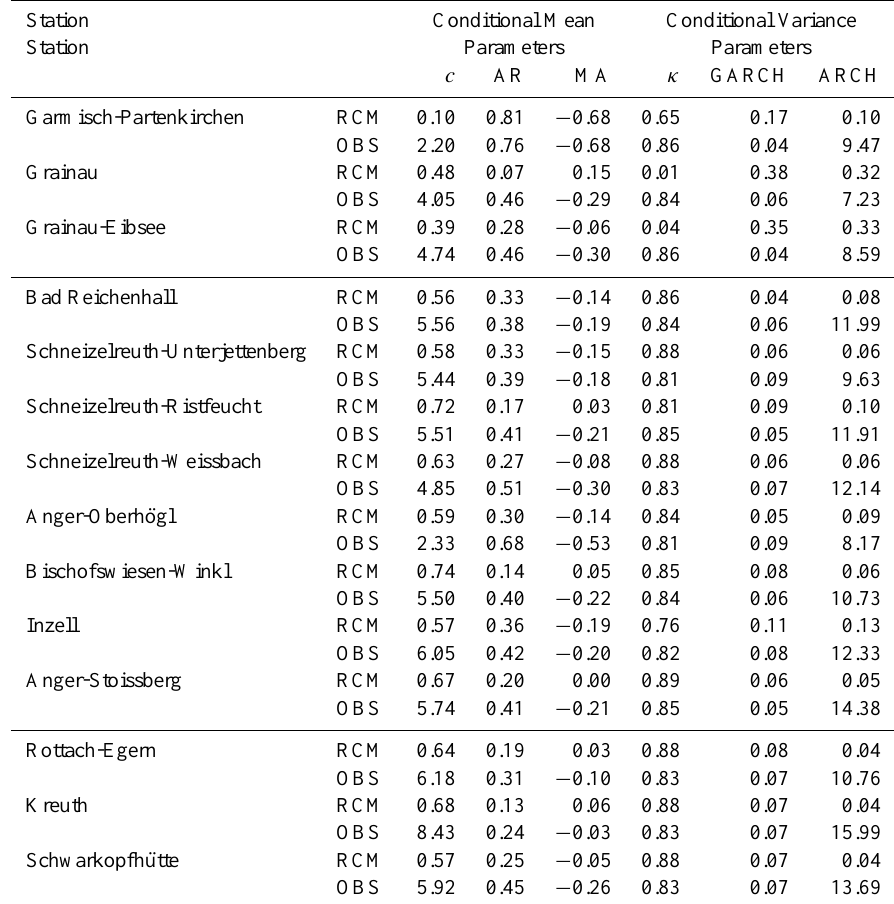
Table 3. Parameters for the fitted ARMA(1,1)-GARCH(1,1) models for selected stations (OBS) and their corresponding RCM grid cells (see Table 1 for further details about the stations). The conditional mean parameters of the ARMA model consist of c , the conditional mean constant, AR, the conditional mean autoregressive coefficient, and MA, the conditional mean moving-average coefficient. The conditional variance parameters consist of κ , the conditional variance constant, GARCH, the lagged conditional variance coefficient, and ARCH, the lagged residual